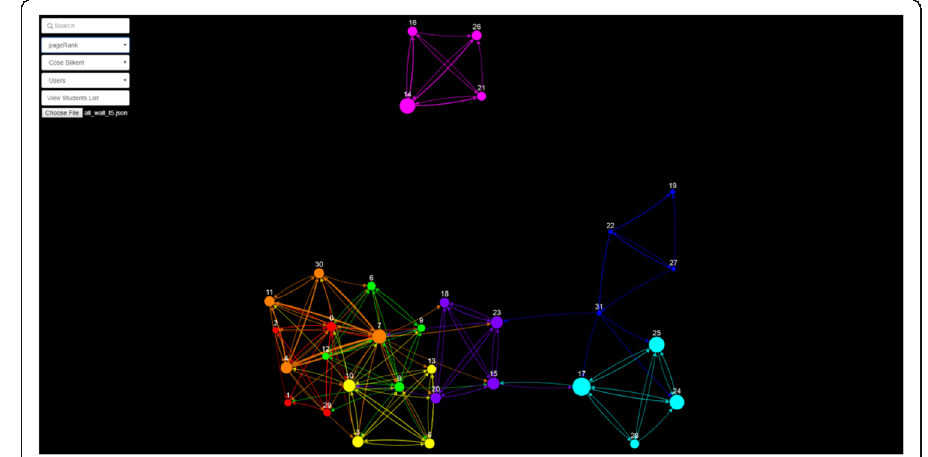
Fig. 8 Students ’ collaboration status in weeks 5 and 6 of the semester. The visualization is provided by StudentViz using Cose-Bilkent layout. Nodes represent students and their diameters are proportional to PageRank metric. Through this image, the instructor can visualize the collaboration status for a specific timeframe, thus being able to observe the evolution of learners ’ collaboration. This figure supports VN1 and VN2, as well P1, P2 and P3